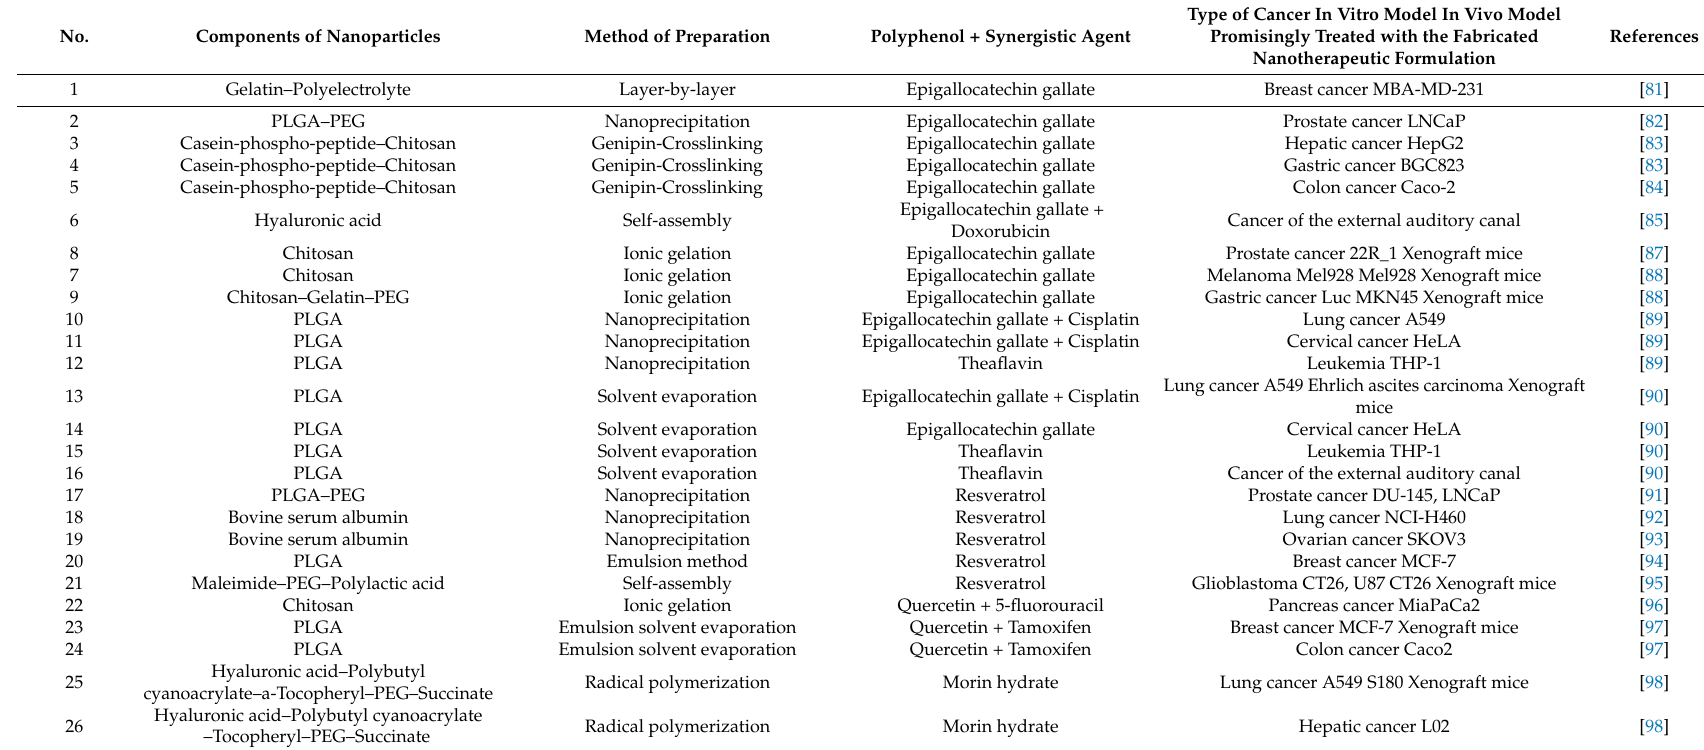
Table 4. Polyphenol-loaded polymeric nanoparticles for the treatment of cancer in